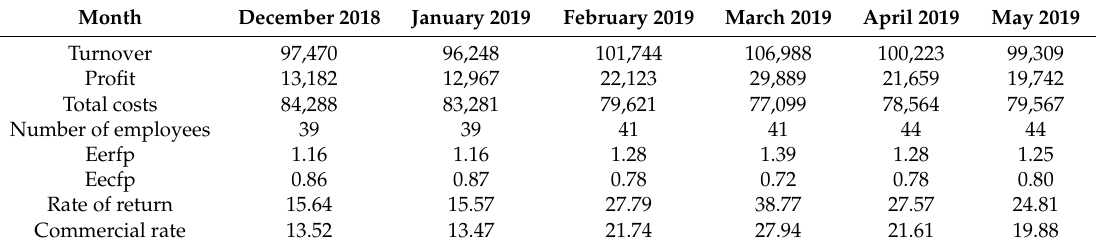
Table 5. The economic situation of the firm in the period December 2018–May